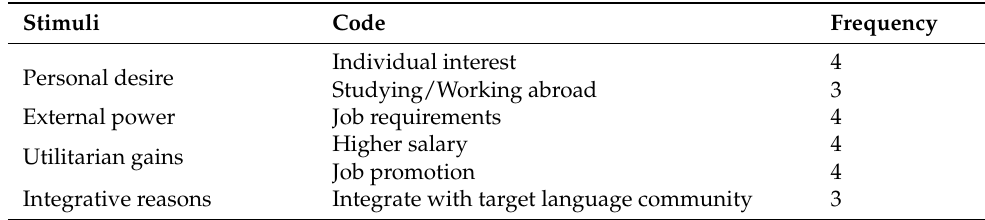
Table 3. Stimuli of English majors in English learning.